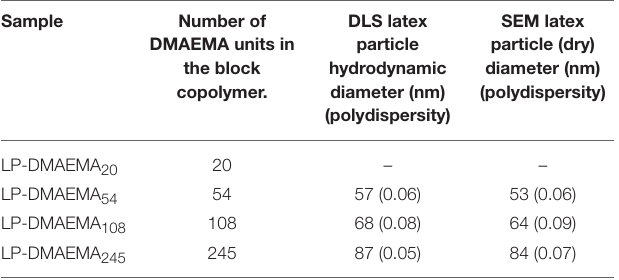
TABLE 2 | Influence of DMAEMA block length on latex particle diameters synthesized with the various diblock copolymers used as stabilizers in the emulsion polymerization